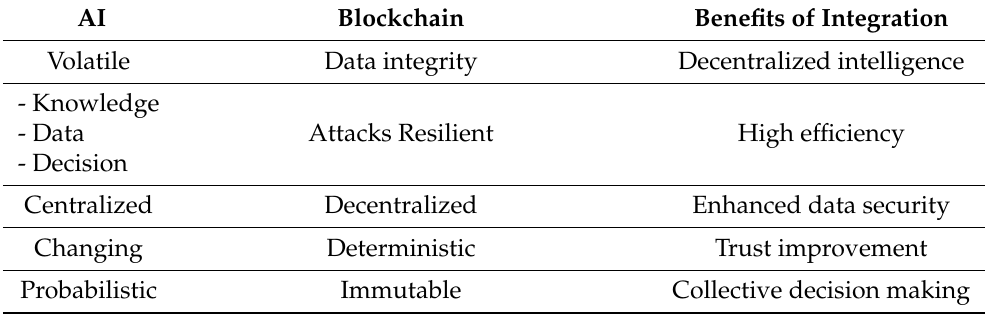
Table 5. Feature extraction of the integrated